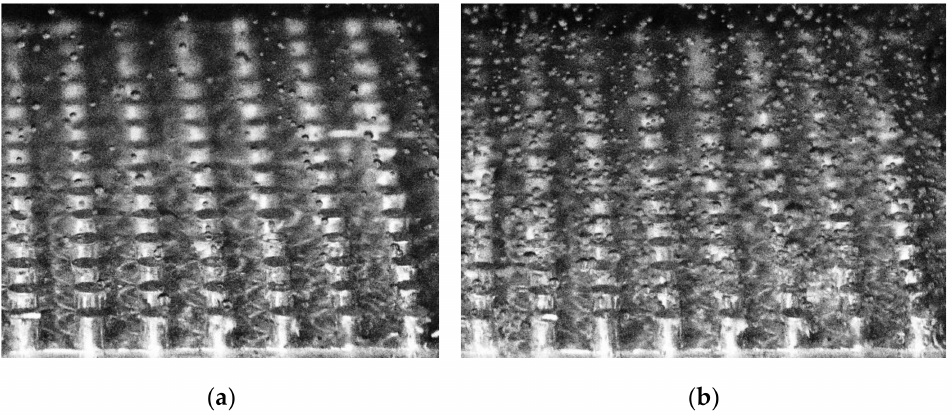
Figure 10. The discrepancy of bubble generation observed from two different heat fluxes: